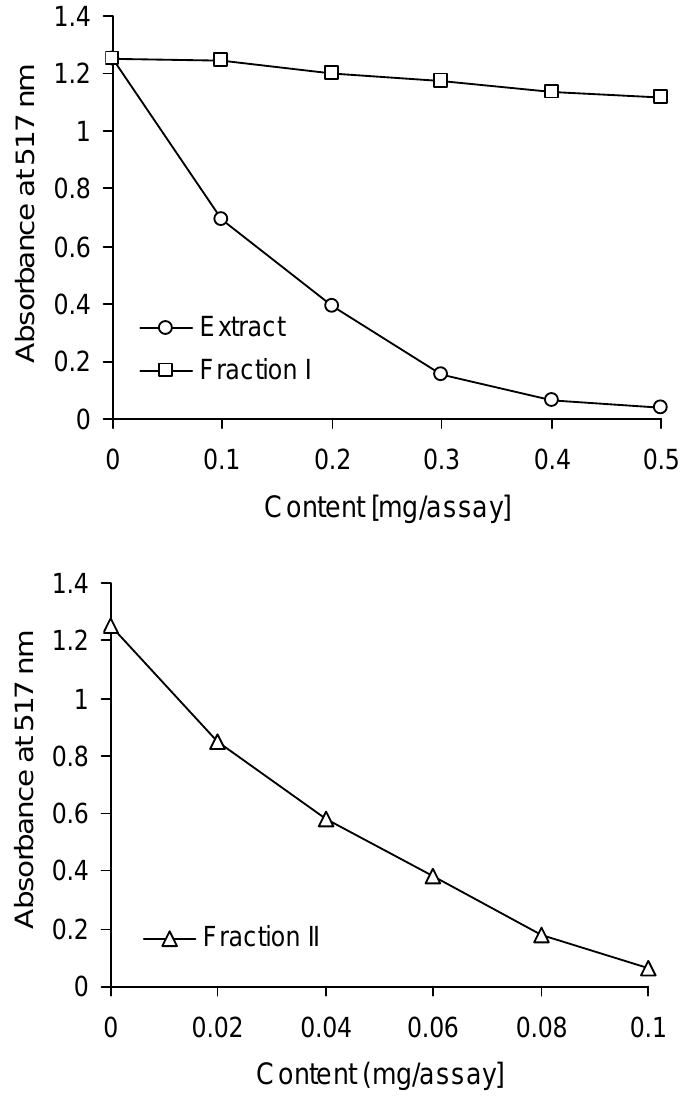
Figure 4. Scavenging effect of a red lentil acetonic extract and its fractions on the DPPH radical, as measured by changes in absorbance at 517